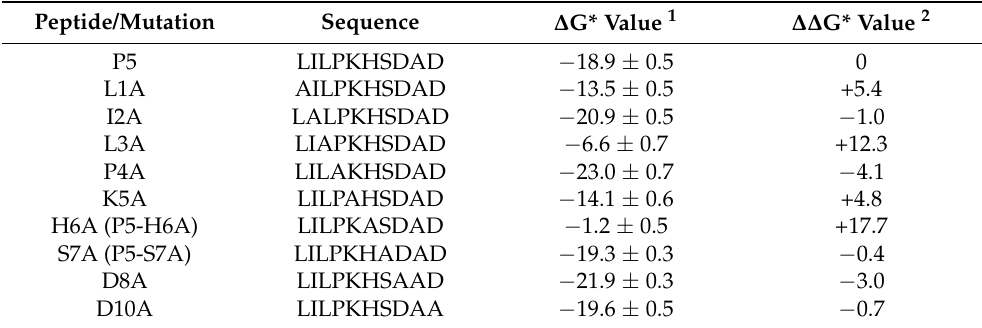
Table 1. Estimated binding free energy values of the peptides under investigation, as calculated using the MM-GBSA approach ( ∆ G*, column